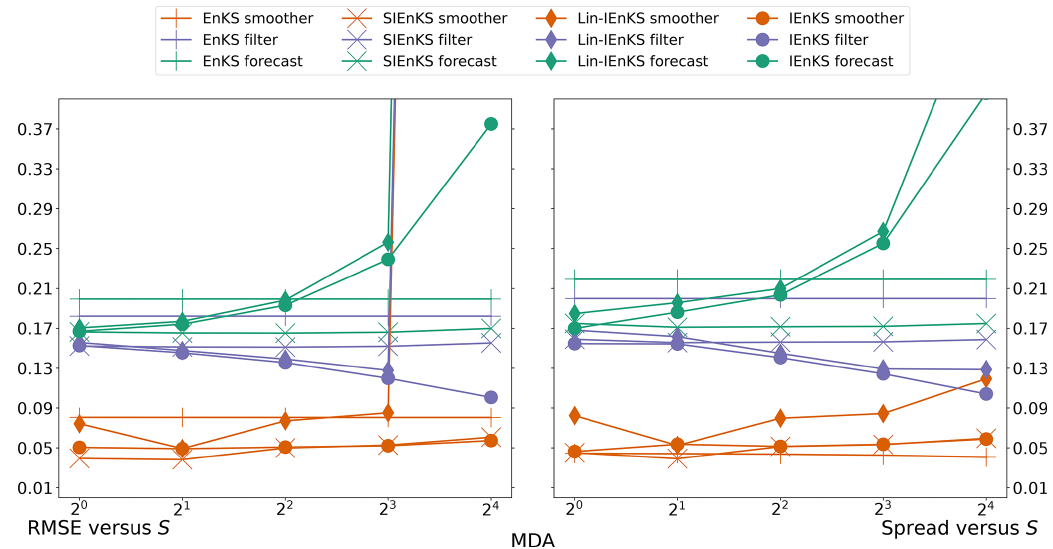
Figure 20. MDA configuration. RMSE and spread versus shift S . Lag L optimized for a minimum forecast RMSE in Fig.